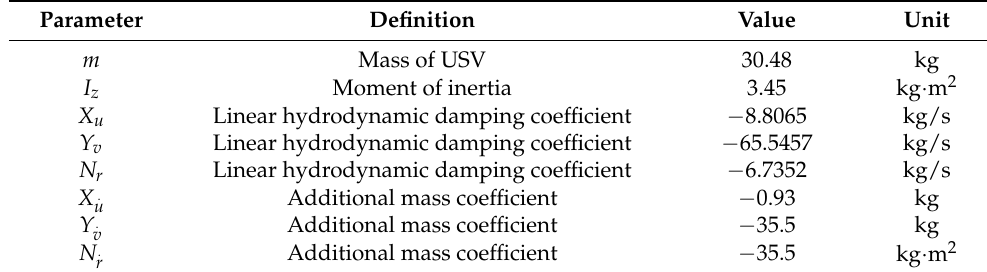
Table 1. Hydrodynamic parameters of the REMUS